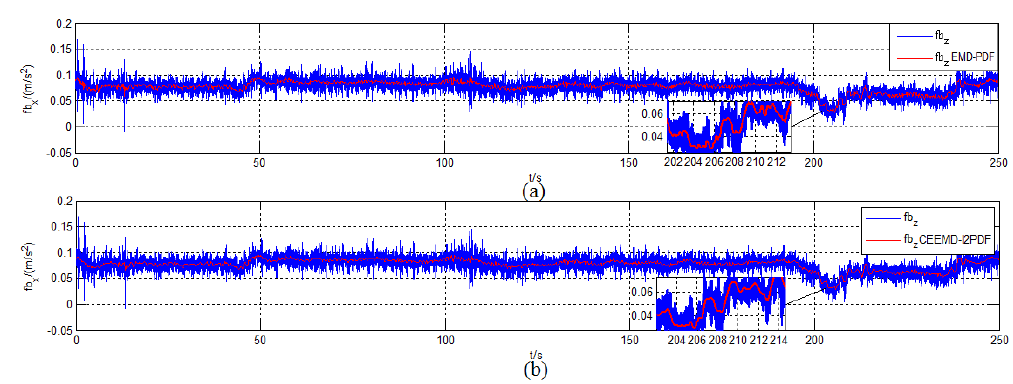
Figure 12. Ship mooring experiment.